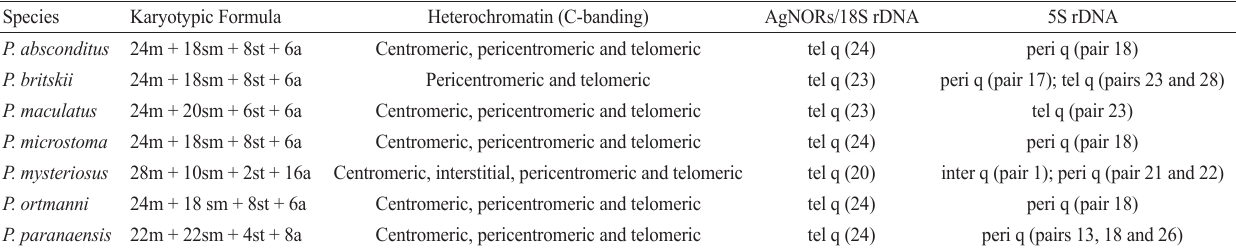
Tab. 3. Cytogenetics data obtained for Pimelodus species. m = metacentric; sm = submetacentric; st = subtelocentric; a = acrocentric; p = short arm; q = long arm; tel = telomeric; peri = pericentromeric; inter =